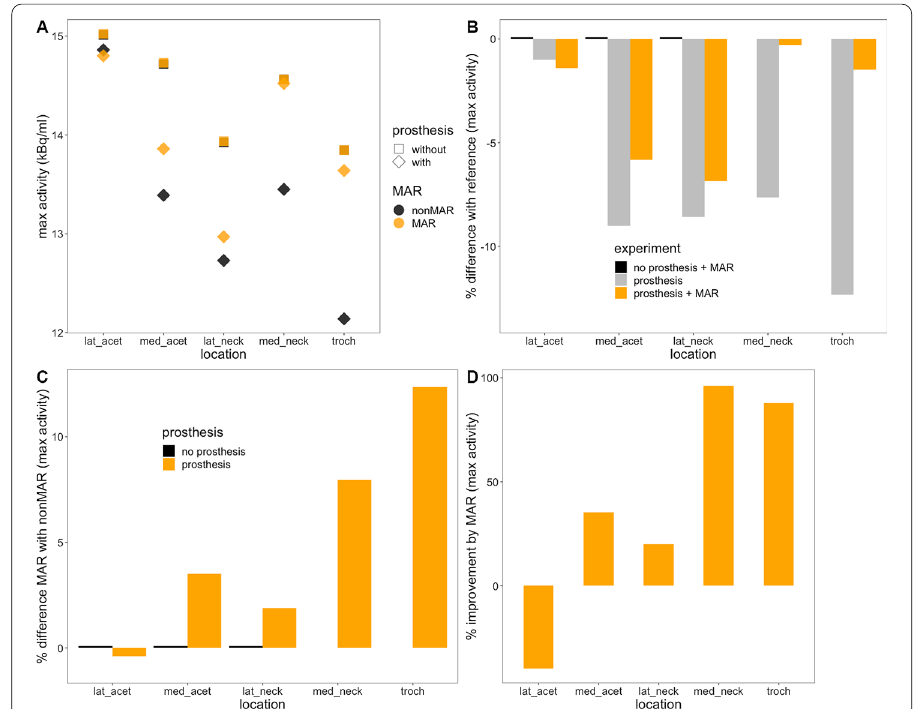
5 sources in the scam and prosthesis experiments using MAR CT (orange symbols) or conventional CT (black symbols) for attenuation correction. Panel B gives the percentual differences between the measurements and the reference value (in the scam experiment without MAR), panel C the differences between MAR and nonMAR PET. Panel D indicates the percentage of the error in the prosthesis experiment that is recovered by MAR. lat_acet lateral acetabular source; med_acet medial acetabular source; lat_neck lateral neck source; med_neck medial neck source; troch trochanteric